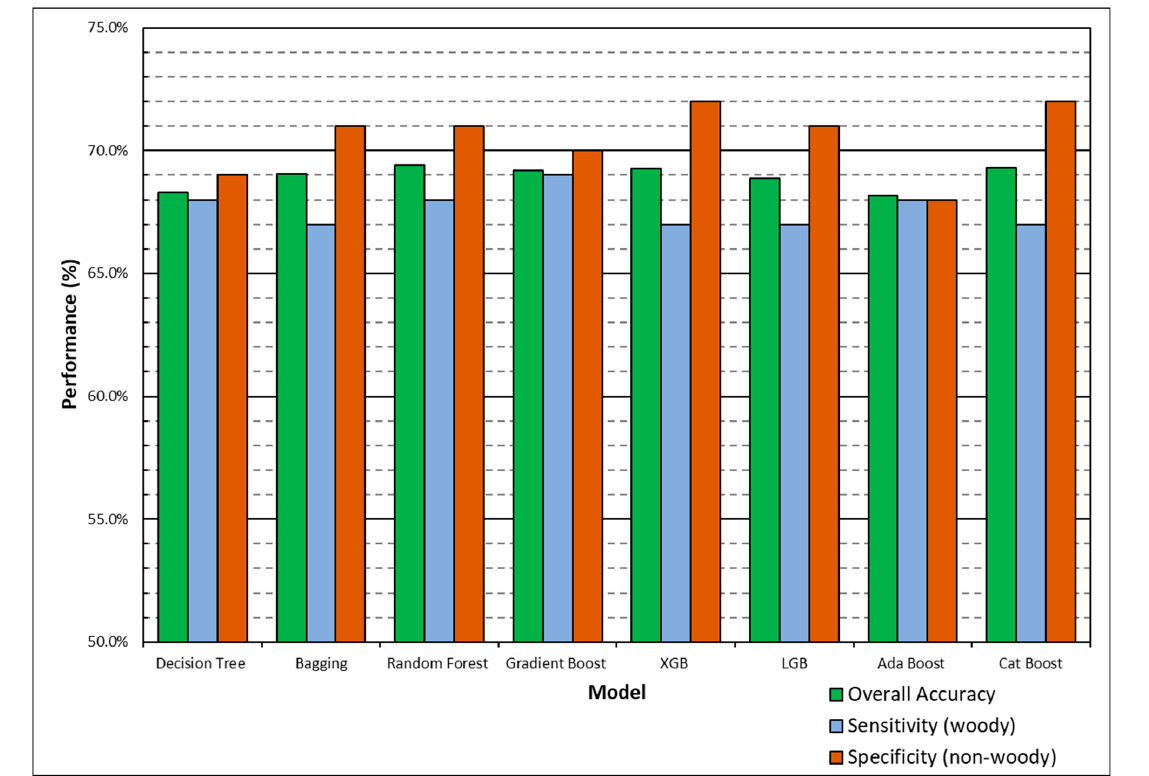
Figure 2. Finalized binary model performance showed a slight improvement at the lower limit of overall accuracy compared to the previous runs (68.2% from 67.8% and 67.0%) and slight decline at the upper limit of overall accuracy (69.4% from 69.8% and 69.5%). Specificity remained higher than sensitivity for all models, with the only improvement from initial models seen in the lower limit of sensitivity (67.0% from 65.0%). Random Forest performed with highest overall accuracy with 69.4% but has a larger difference between sensitivity and specificity compared to Gradient Boost, which has an overall accuracy of 69.3%. Lowest sensitivity was observed from the Bagging, eXtreme Gradient Boost, Light Gradient Boost, and Cat Boost models (67%) and highest sensitivity was observed from the Gradient Boost model (69%). Lowest specificity was observed from the Ada Boost model (68%) and highest specificity was observed from the eXtreme Gradient Boost and Cat Boost models (72%).